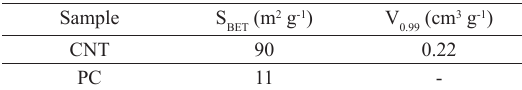
) and total volume of pores (V BET adsorption-desorption 2